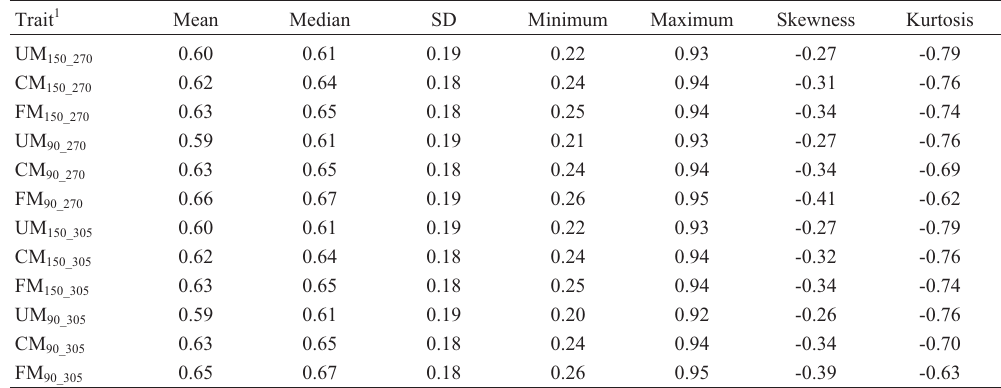
Table4 -Mean,median,standarddeviation(SD),skewness,kurtosis,minimumandmaximumvaluesofbreedingvalueestimatesforthestudiedtraits. Trait